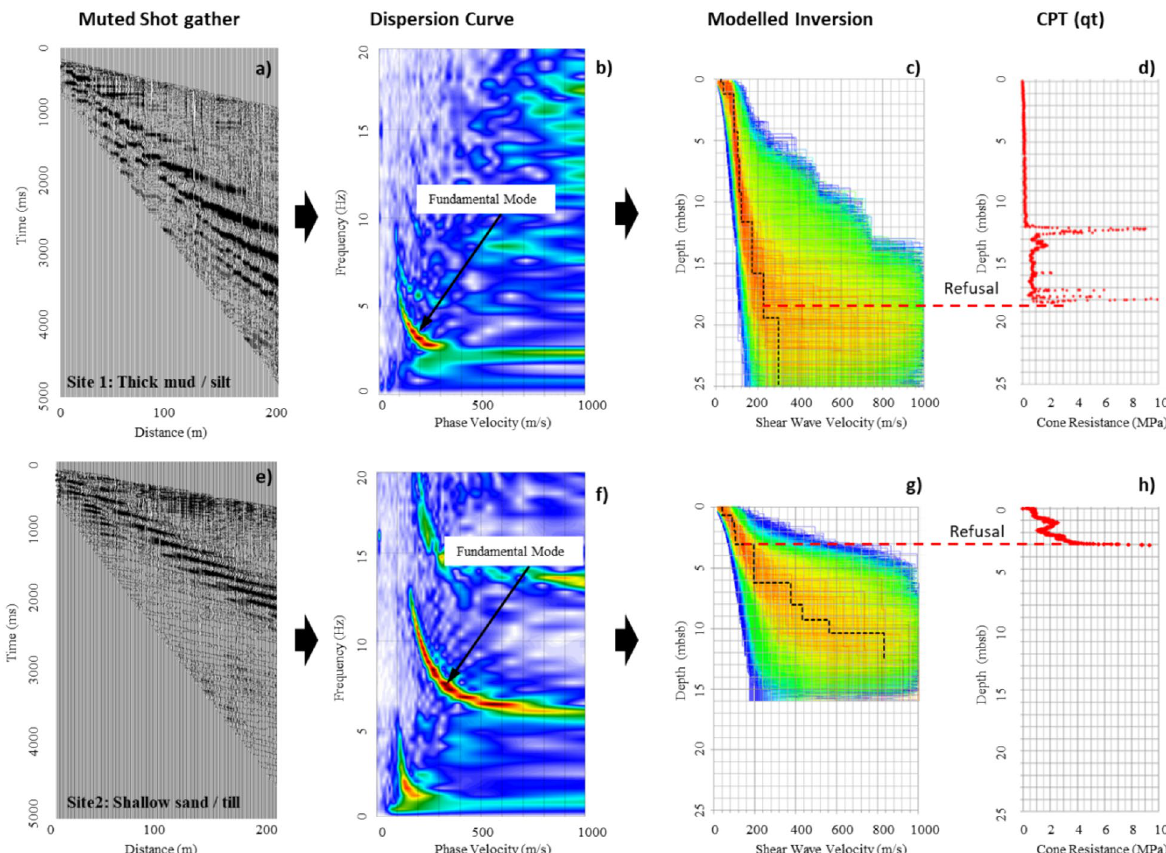
Figure 3. Processing flow for Site 1 ( a – d ) and Site 2( e – h ), showing (a,e) muted shot gathers, ( b , f ) dispersion curve images, ( c , g ) inverted profiles, with best fit velocity models (dashed black lines), ( e , h ) correlation of modelled inversion to Cone Penetrometer Testing (Cone Resistance,